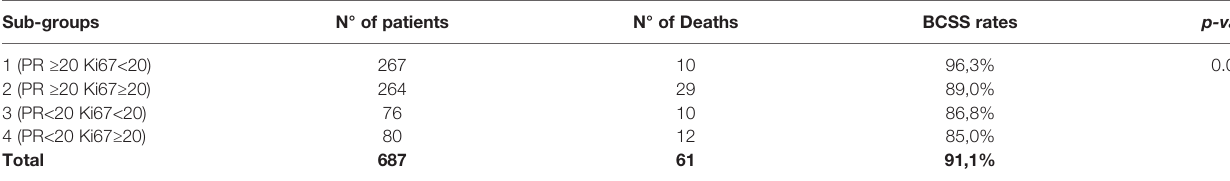
TABLE 2 | Breast cancer speci fi c-survival rate according to different PR and Ki67 expression levels. Sub-groups